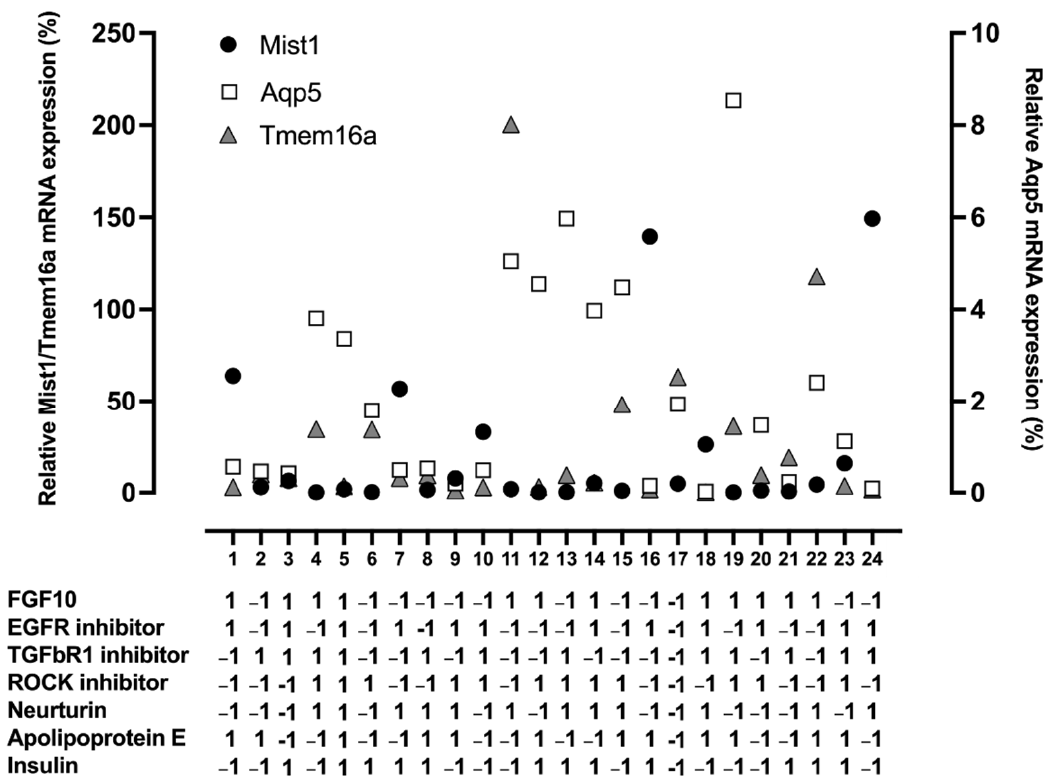
Figure 2. Individual runs of the Plackett–Burman show changes in relative mRNA expression. Scatter plot of the relative mRNA expression of the three responses, Mist1 (black circles), Aqp5 (white squares), and Tmem16a (gray triangles), for the Plackett–Burman screen. Each tick on the x-axis corresponds to the run number, with the levels ( − 1 or 1) of each factor shown underneath. mRNA expression is relative to the housekeeping gene Rps29 and day 0 tissue. Relative Aqp5 mRNA expression is plotted on the right y-axis and relative Mist1 and Tmem16a mRNA expression are plotted on the left y-axis.